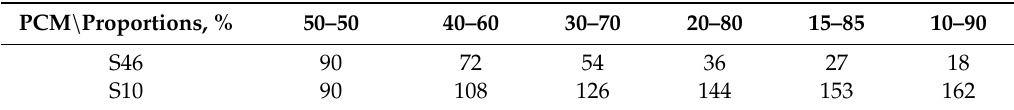
Table 2. Proportions and the number of S46 and S10 containers in the 2000-L tank, which were analyzed in the model